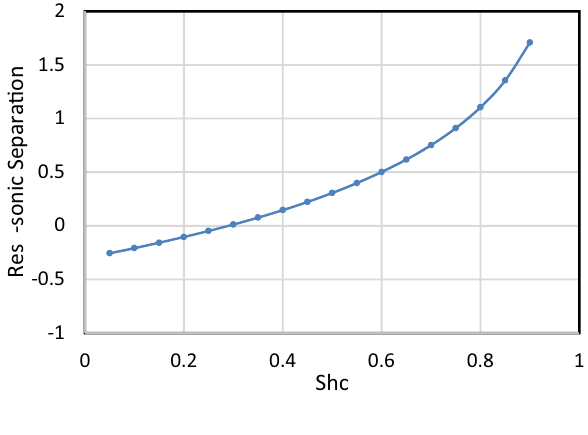
Fig. 15 S hc versus separation for